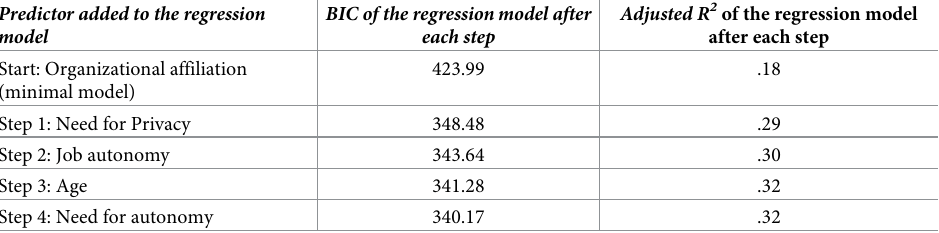
Table 3. Steps in the model selection